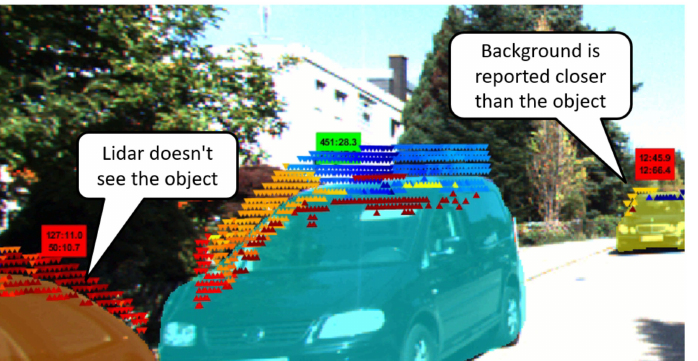
Figure 2. Example of incorrect measurements provided by Velodyne LiDAR. The color represents the distance, with the scale adjusted for each object